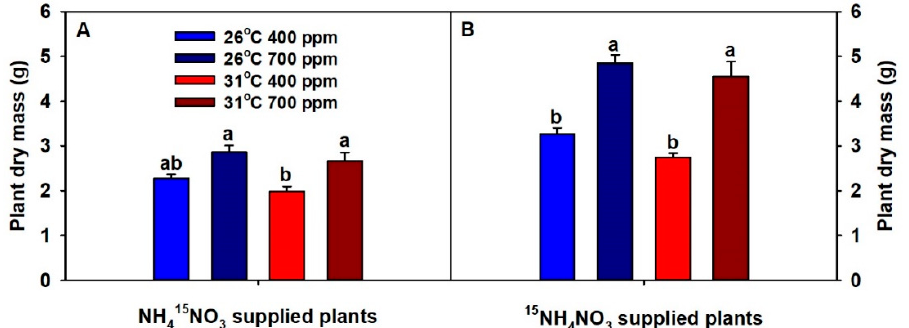
Figure 1. The effects of ambient (400 ppm) vs. elevated (700 ppm) CO 2 and near-optimal (26 °C) vs. chronic warming (31 °C) daytime temperatures on total plant dry mass of Triticum aestivum cv. Glenn labeled for 3 days with 1 mM (A) NH 415 NO 3 or (B) 15 NH 4 NO 3 and grown for 21 or 23 days, respectively. Each bar represents mean ( n = 4 or 5) + 1 standard error of mean (SEM). Within each panel, bars not sharing the same letters are significantly different ( p < 0.05, Tukey’s test). − Across both temperatures, eCO 2 significantly decreased plant %N (except 15 NO 3 supplied plants ◦ at 26 C), while chronic warming did not influence %N (Figure 2A,B). Notably, %N was lowest in − plants grown at eCO 2 plus warming. Across both temperatures, eCO 2 decreased NO 3 -uptake rate + ◦ (more so at 26 C) and NH 4 -uptake rate (Figure 2C,D). In contrast, chronic warming did not a ff ect + − NO 3 -uptake rate but did marginally increase NH 4 -uptake rates (Figure 2C,D). Among all treatment + − combinations, NH 4 -uptake rates were consistently greater than NO 3 -uptake rates.